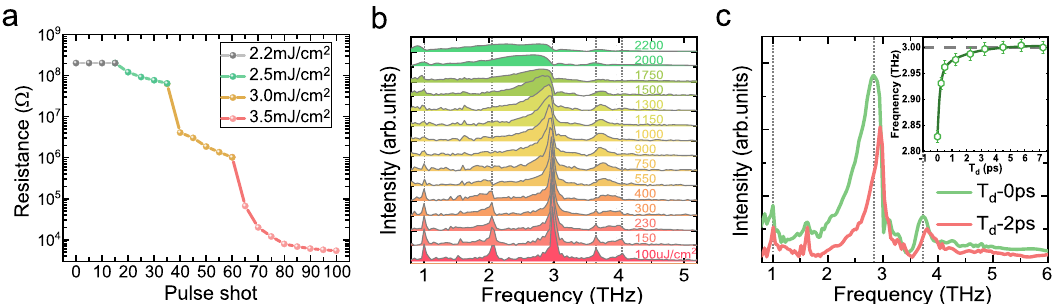
Fig. 4 Pulse fl uence threshold and Fluence dependent PI state properties. a Shot-to-shot resistivity change of Ta 2 NiSe 5 ultrathin sample at 50 K. Each shot includes a sequence of fi ve pulses. b Fluence dependent coherent phonon spectra for moderate fl uences at 50 K. The energy of probe pulse kept constant in a small value of ~3 μ J/cm 2 . The dashed are guidelines. c The red-shift effect of the 3.0 THz mode as a function of the time delay T d for incident 1.5 mJ/cm 2 . The inset shows an exponential approximation recovery to the initial frequency, where the error bar is the standard deviation evaluated when extracting the peak frequency from the coherent